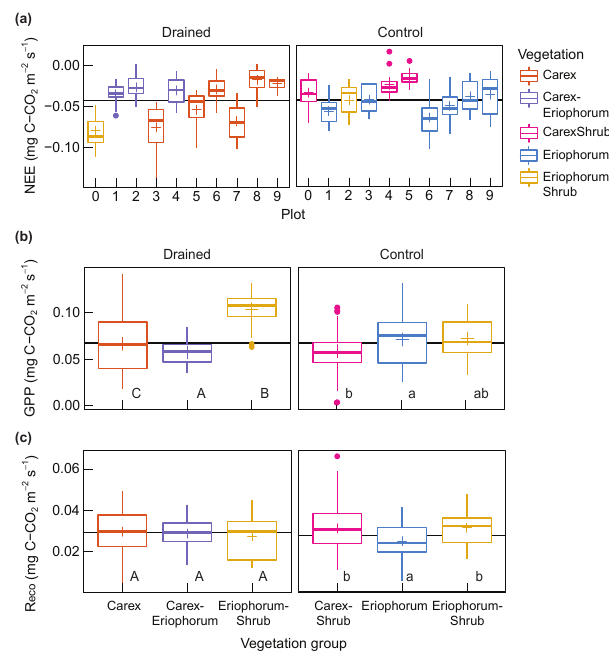
Figure 8. (a) Variability of NEE among individual plots during the 2013 growing season. Boxplot contains median, 25 and 75% quar- tiles, ± 1.5 interquartile ranges, as well as mean values with cross points per plot. The black horizontal bars show the mean flux rates averaged for the entire transect. (b) GPP and (c) R eco rates aggre- gated by the vegetation group. Significance of differences between groups, determined by one-way ANOVA and Tukey’s post hoc test, is indicated by the letters. Different letters indicate significant dif- ferences between groups while the same letters indicate significant